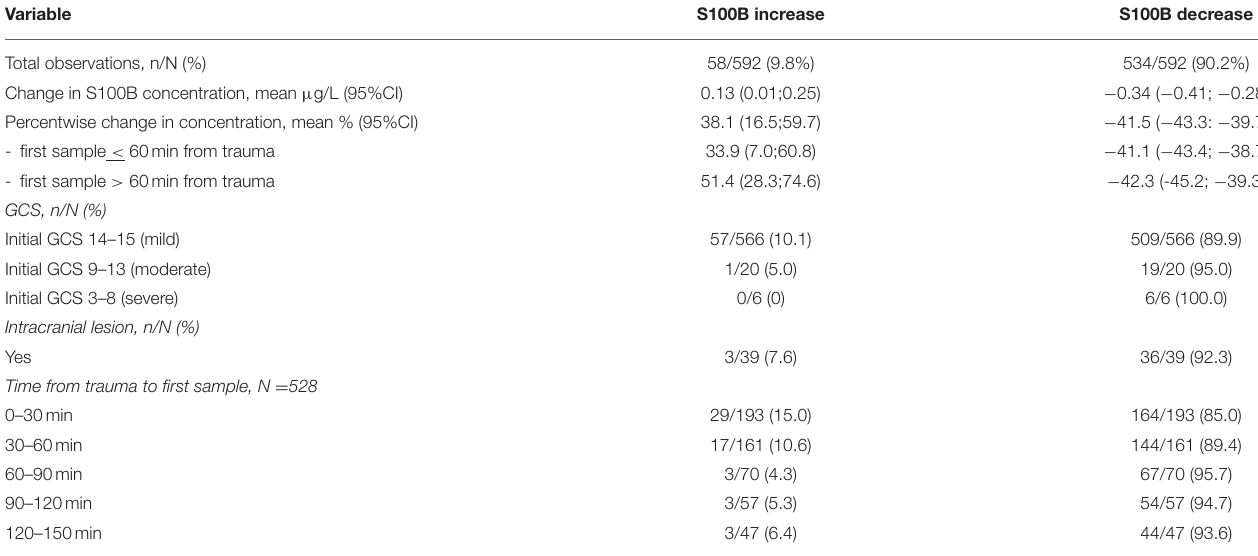
TABLE 3 | Trajectory of S100B between prehospital and in-hospital concentrations (S100B increase or decrease) stratified by (1) initial GCS, (2) intracranial lesion, and (3) time from trauma to first (prehospital) sampling in 30min intervals, N = 592. Variable